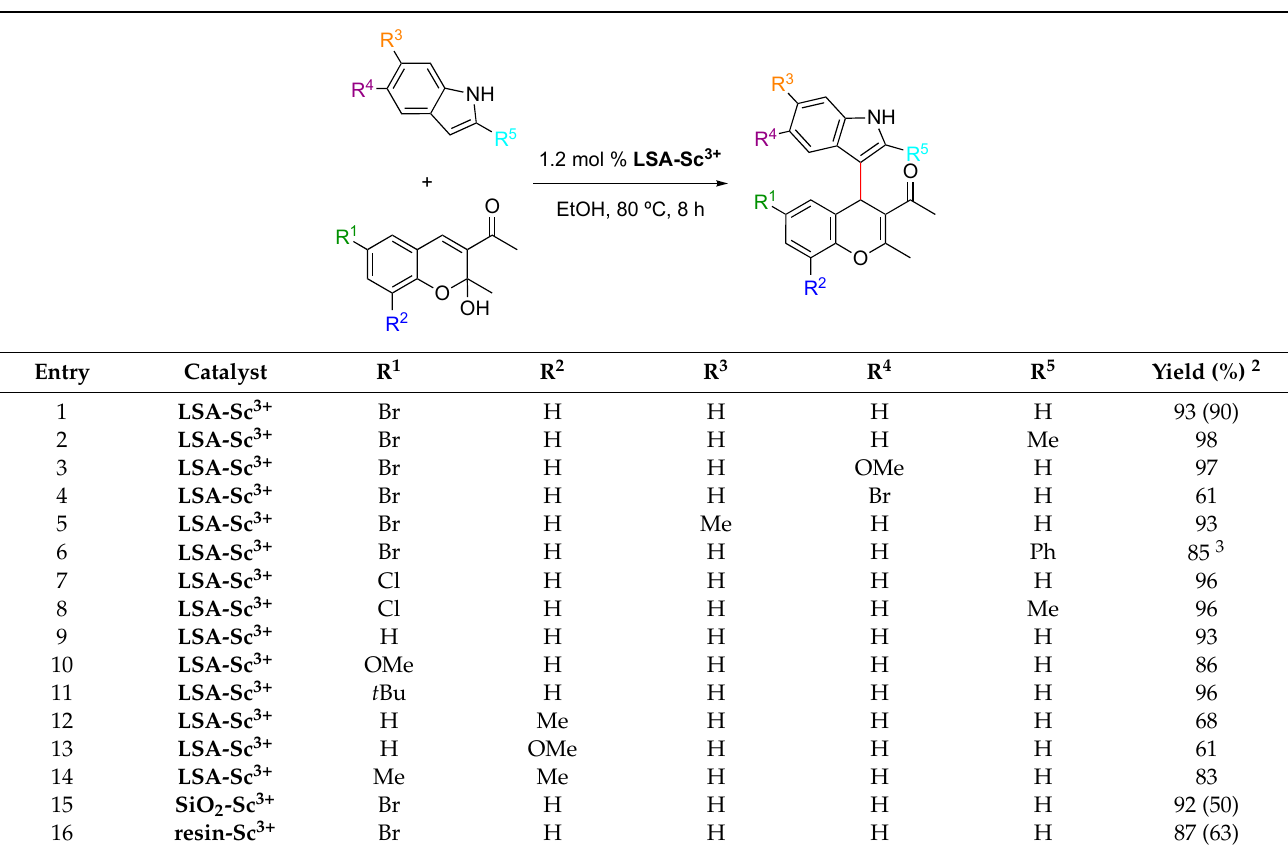
Table 2. LS-Sc 3+ promoted the Michael addition/dehydration tandem reaction between 3-acetyl-2- hydroxy-2-methylchromenes and indoles [33] 1 .